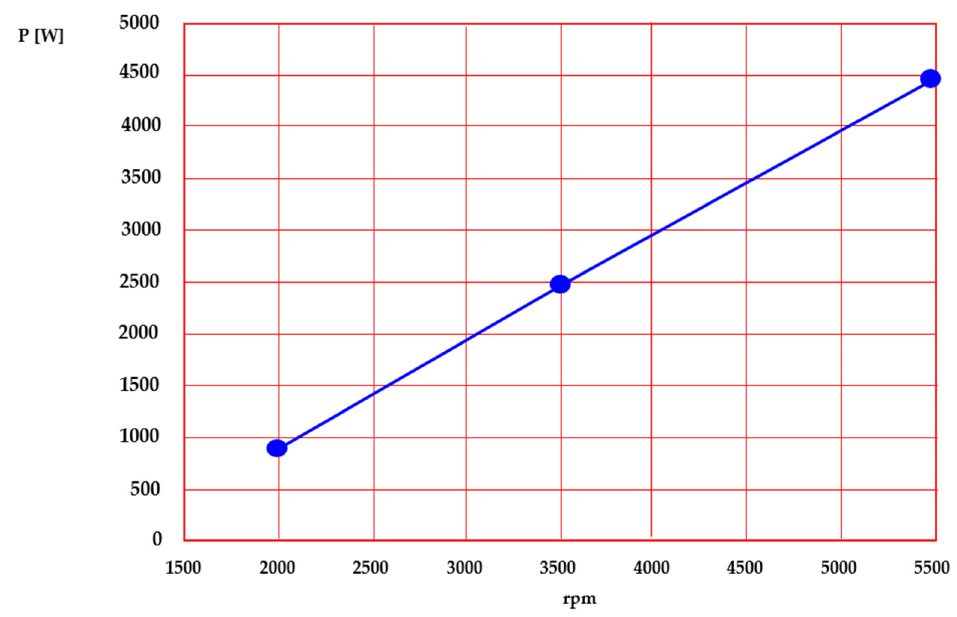
Figure 3. Required power as a function of the rotation speed of the ICE engine.